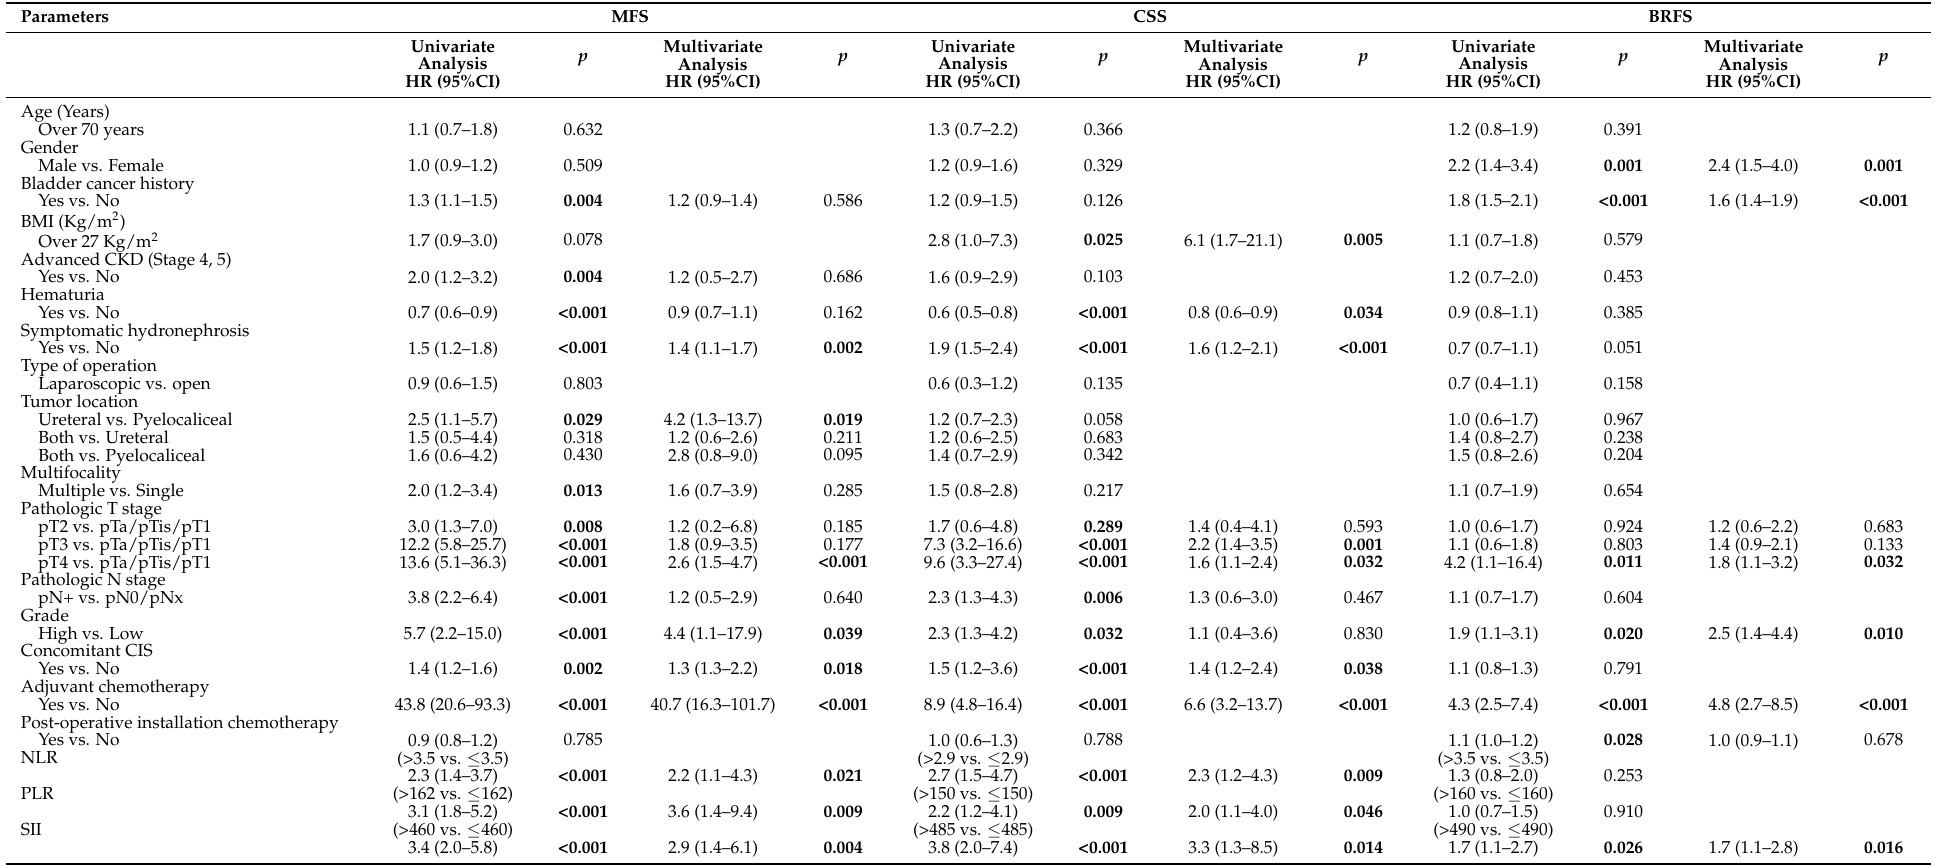
Table 2. Univariate and multivariate analyses predicting CSS, MFS and BRFS in patients ( n = 376) with UTUC after